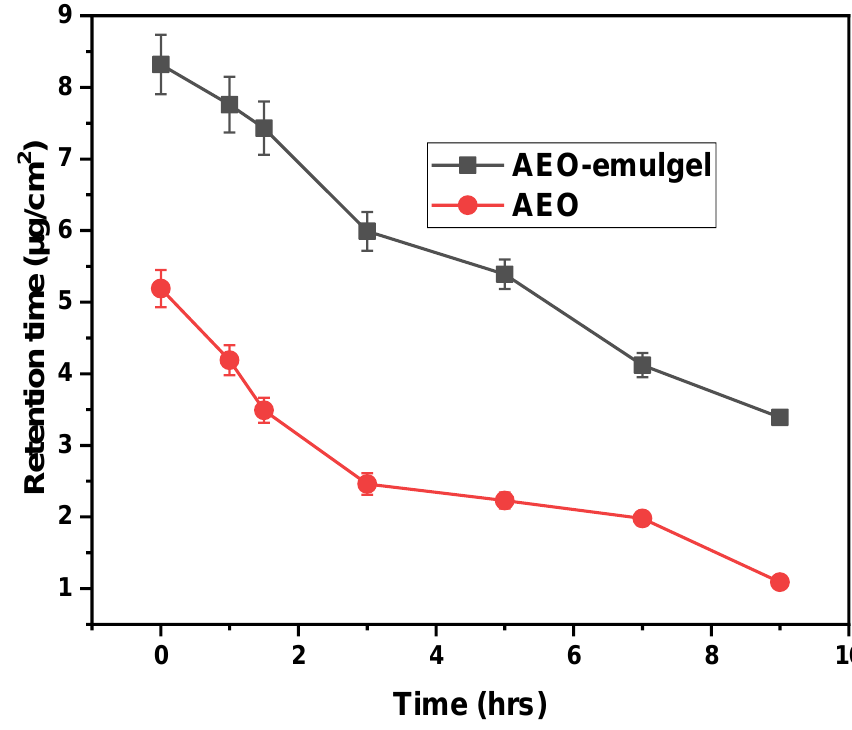
Figure 4. Ex-vivo retention studies of AEOs emulgel for 9